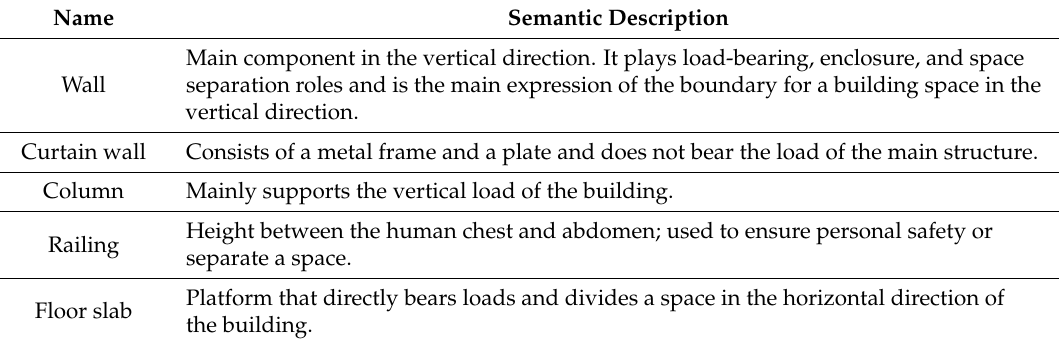
Table 1. Building